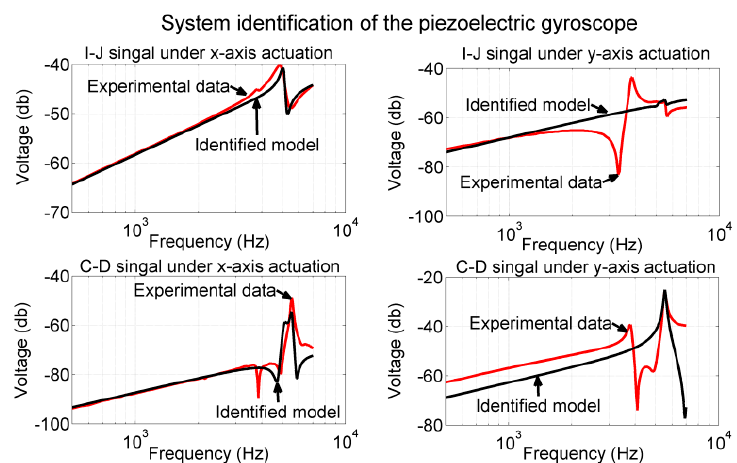
Figure 17. System identification for the overall system. Identified models matched well with the measurements of the sense electrode near the resonant frequencies.